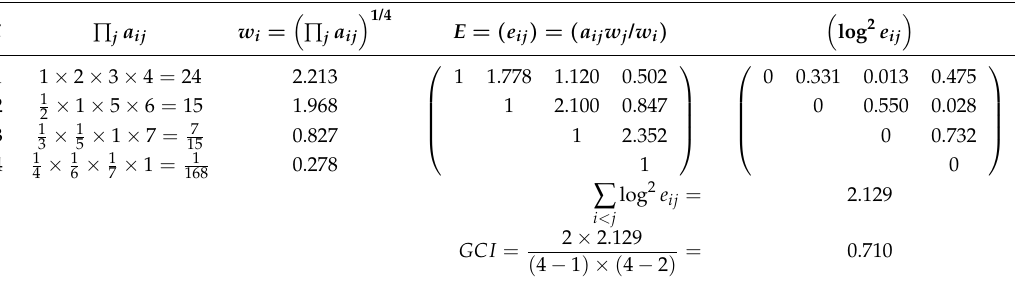
Table 3. Calculation of the GCI .